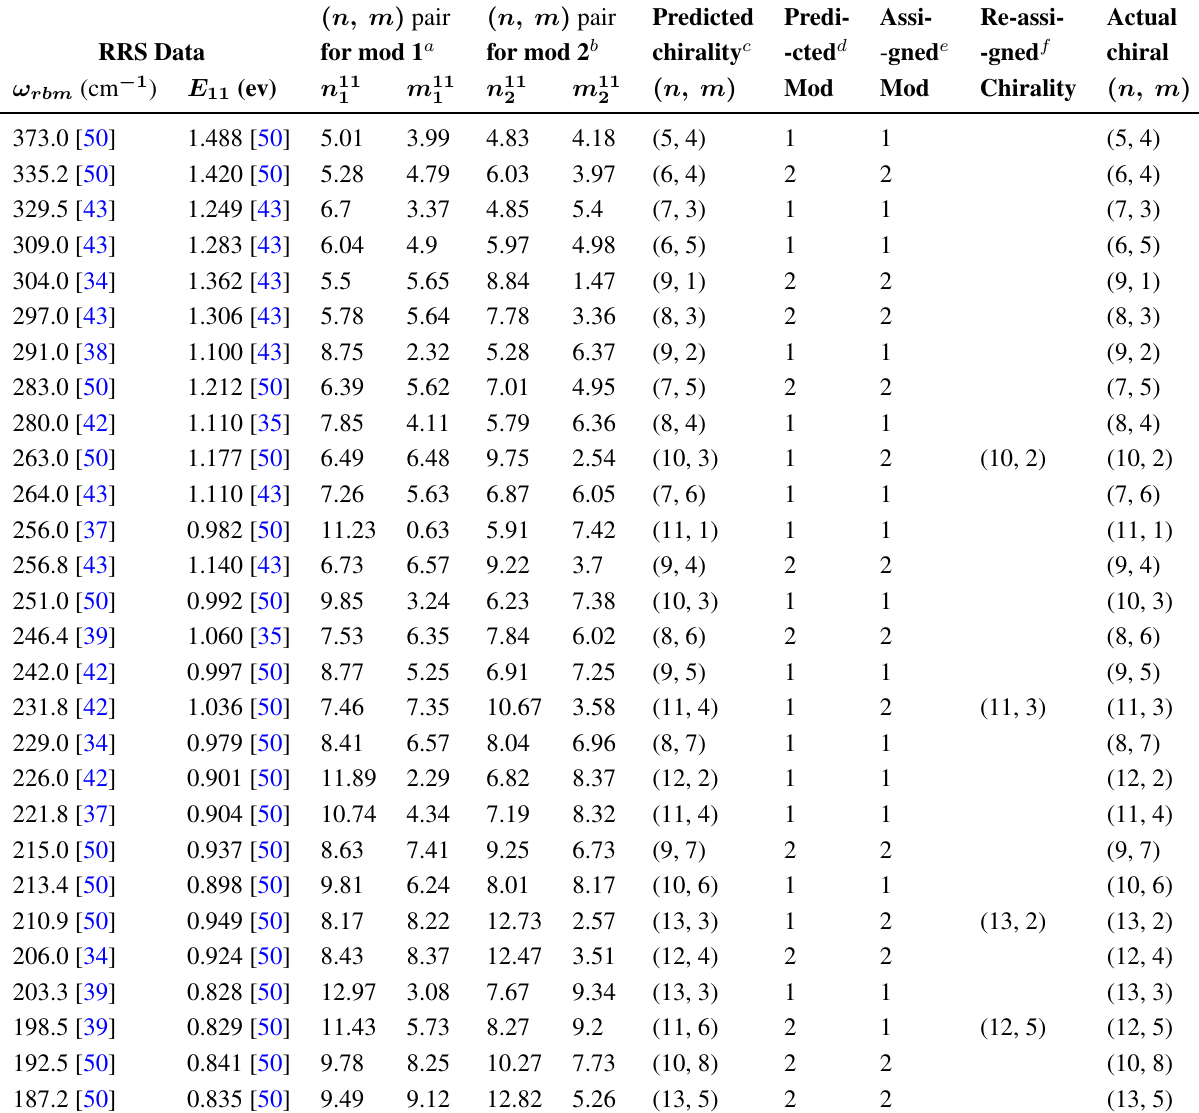
Table 3. Chirality Assignment of 28 semiconducting SWCNTs from E 24 of them are rightly assigned as the predicted and assigned mod type matched. The remaining four semiconducting SWCNTs are further treated using error detection and refining